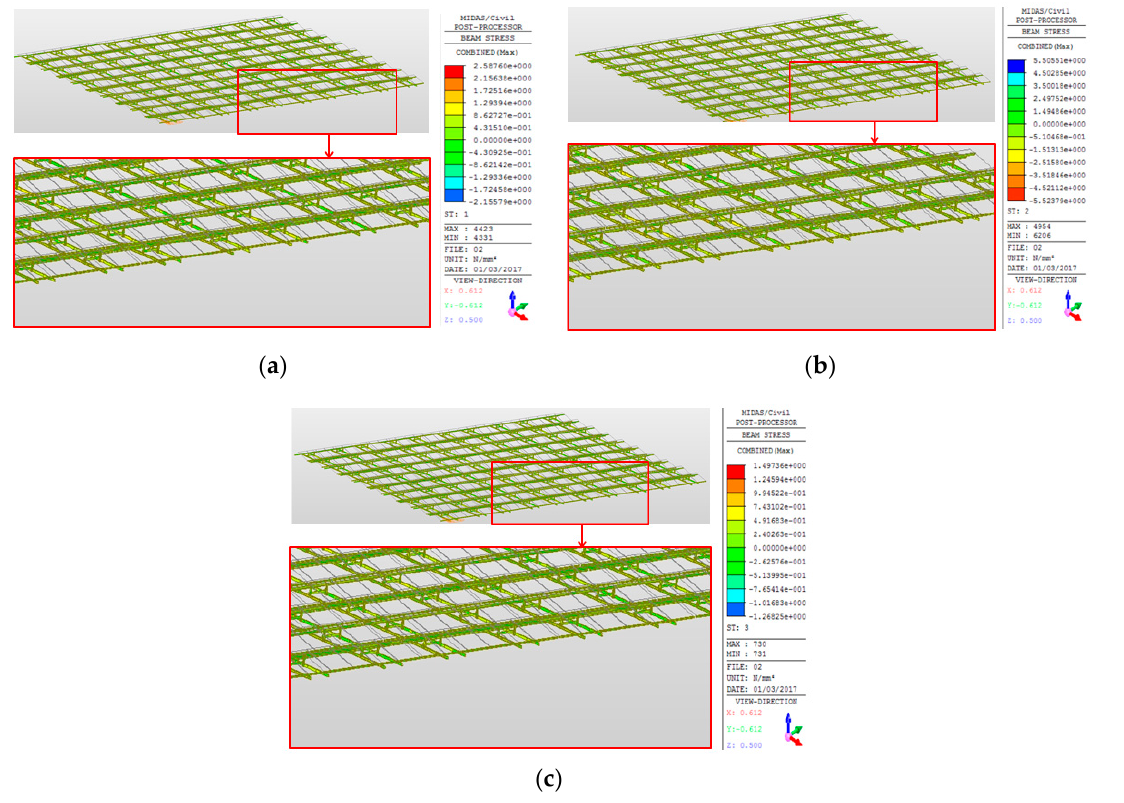
Figure 14. Stress distribution of the structure according to wave height. ( a ) Case 1; ( b ) case 2; ( c ) case 3. Table 6. Results of finite element analysis considering wave height.